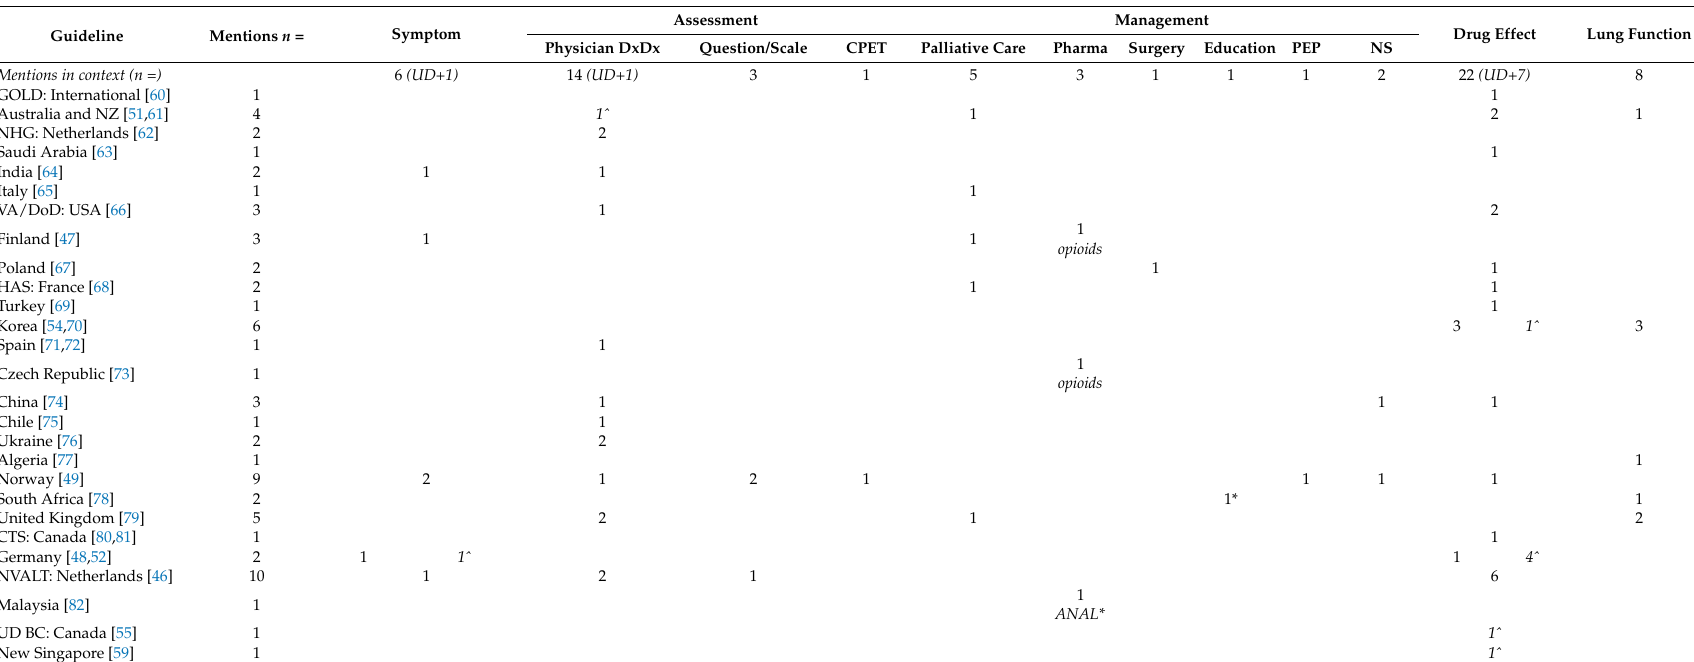
Table 1. Mentions of “pain” in specific contexts within the clinical practice guidelines for the management of